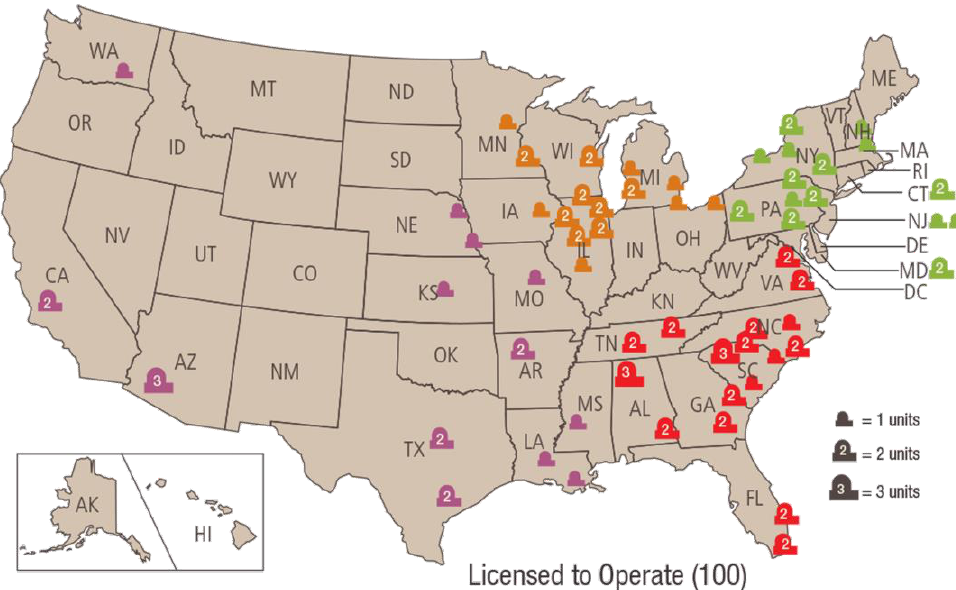
Figure 5. Operating Commercial Power Plants In U.S. – November 2015 (Source: U.S. Nuclear Regulatory Commission, http://www.nrc.gov/reactors/operating/map-power- reactors.html , accessed 24 August 2016)